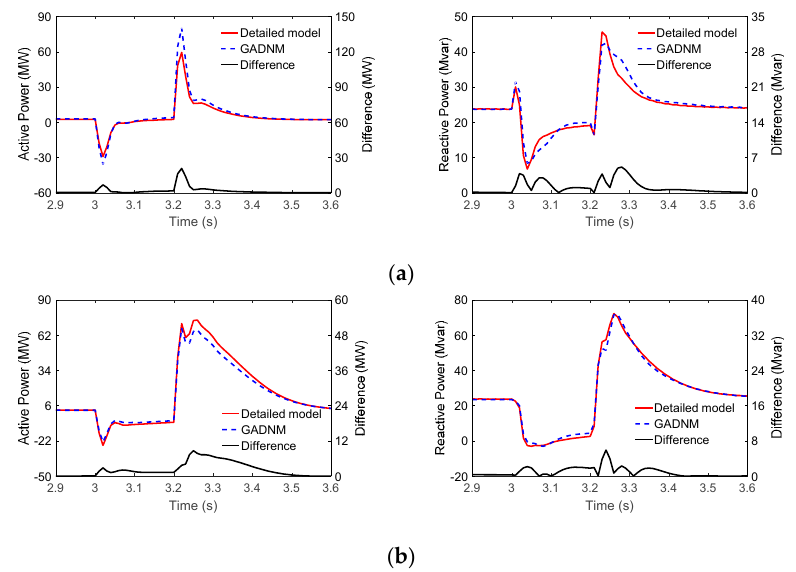
Figure 10. Responses of two voltage dip disturbances with K DG = 100%. ( a ) 20% U n voltage dip. ( b ) 70% U n voltage dip. Table 2. Estimated results of the parameters in the GADNM.